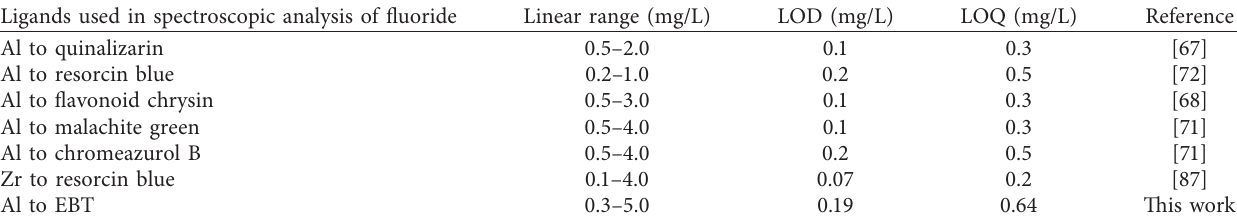
Table 4: Comparison method validation parameters with previously reported